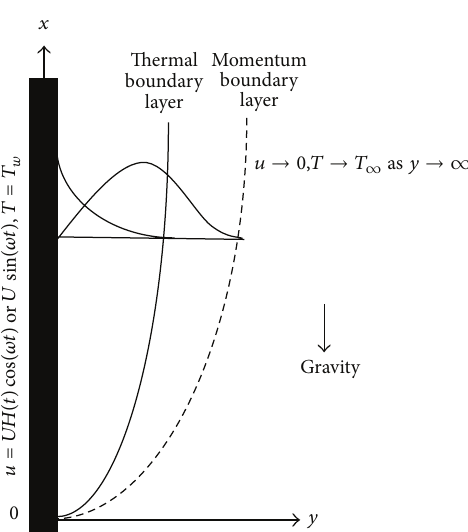
Figure 1: Physical model and coordinate